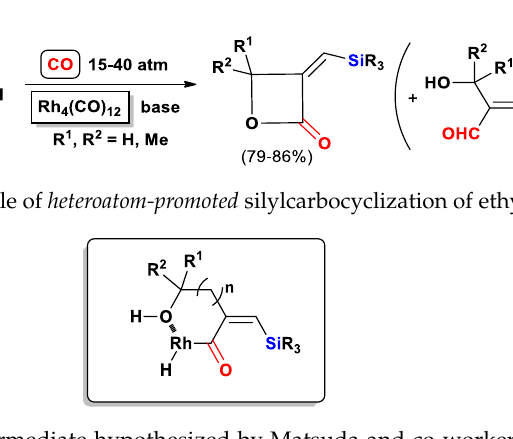
Figure 1. Rhodium-acyl intermediate hypothesized by Matsuda and co-workers in the heteroatom-promoted SiCAC of propargyl alcohols.